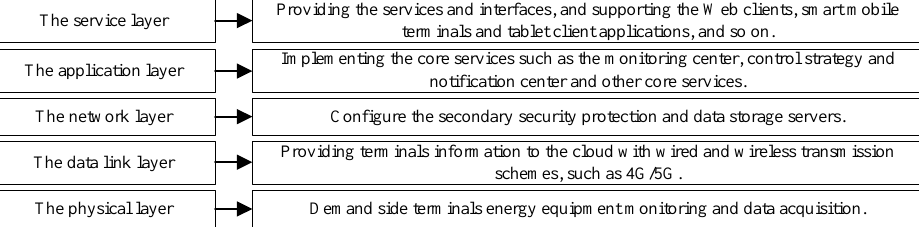
Figure 2. The information interconnection architecture.